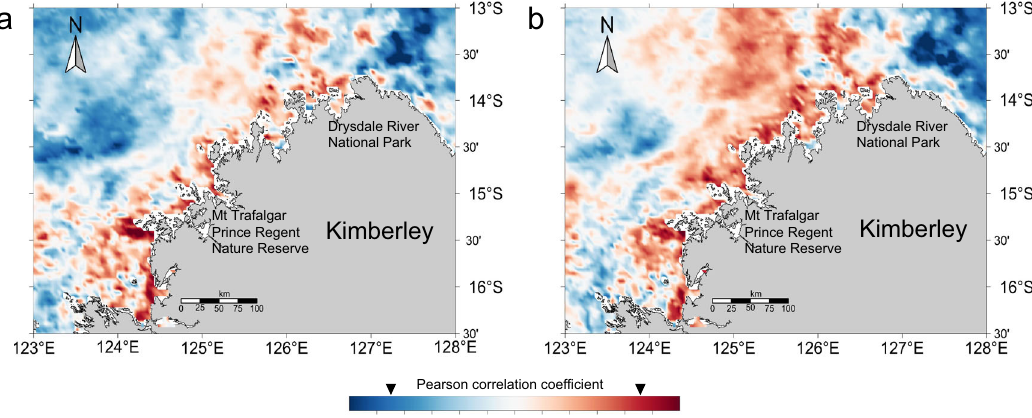
Fig. 4 Spatial distribution of Pearson correlation coef fi cients between Chl-a, BC, and BSi during 2003 – 2017. a Chl-a and BC. b Chl-a and BSi. (two-sided analysis, n = 17; Inverted black triangles on the colour bar showing signi fi cance ( p < 0.05) when the correlation coef fi cients were below − 0.456 and over 0.456).